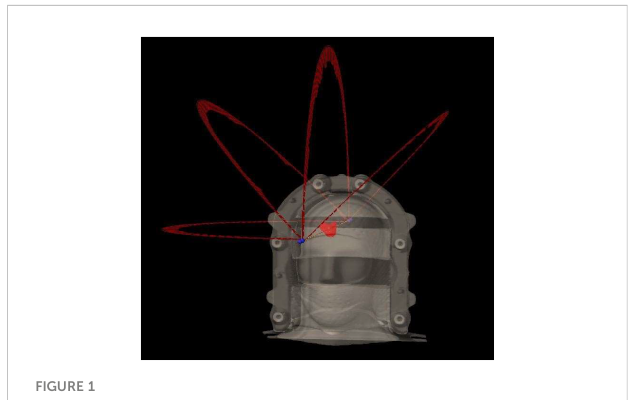
FIGURE 1 Typical beam arrangement of a HyperArc plan in this study, consisting of four non-coplanar 180° arcs at couch angles of 0, 45°, 90°, and